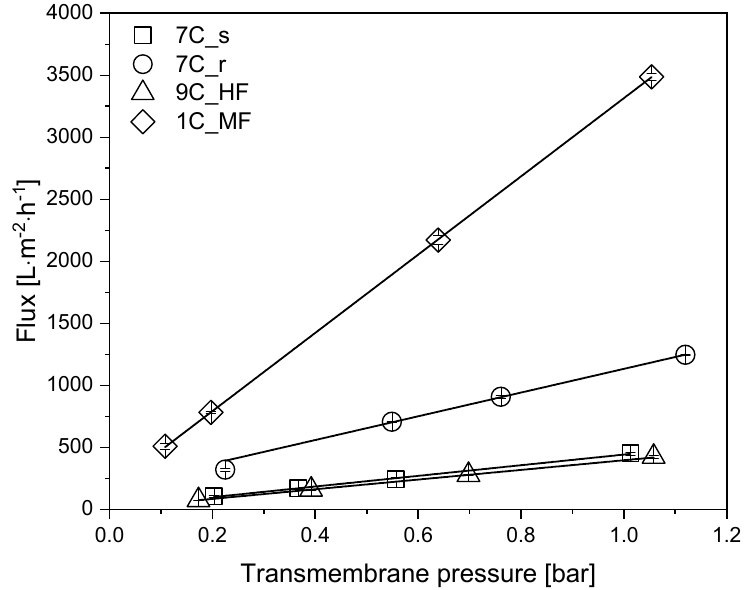
Figure 3. TMP-dependent pure water flux of each membrane. Solid lines indicate linear fits. Data are means ± standard deviations (n = 3). The coefficient of determination R 2 for each fit was >0.98.